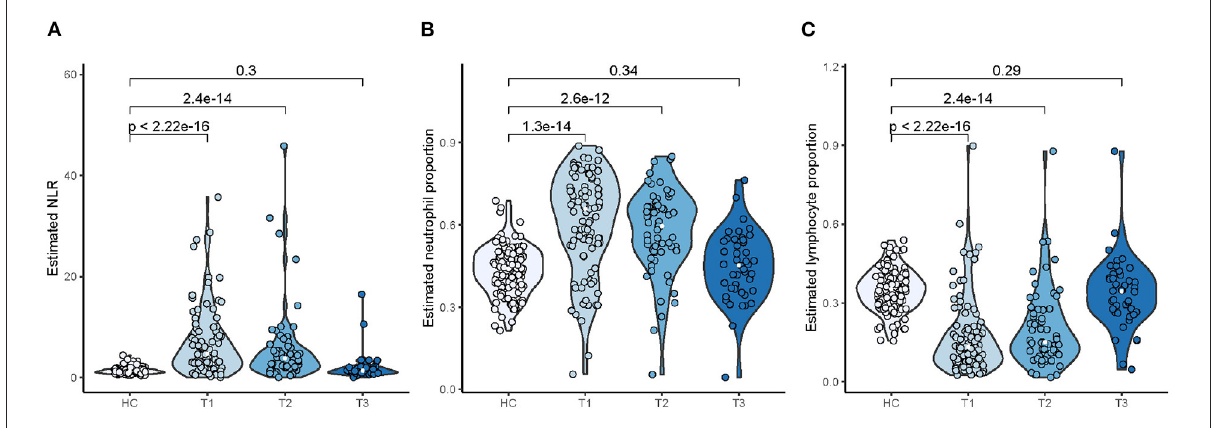
metabolism, such as genes encoding the ribosomal proteins (Figure 14A) involved in viral gene expression and transcription, RNA catabolic process, translational initiation and protein targeting to ER, and genes encoding the mitochondrial complex I (NADH: ubiquinone oxidoreductase) subunits (Figure 14B) involved in cellular respiration, as well as genes IMP3, NOP56, NOP2, QTRT1 involved in ncRNA and rRNA metabolic processes, ribonucleoprotein complex biogenesis, and ribosome biogenesis. For the salmon module involved in regulating cell cycle, the DEGs still displayed a broad downregulation in the SI group (Figure 13C). For the blue module involved in cellular signal transduction, the DEGs displayed an opposite trend of expression with an increased expression in the SI group (Figure